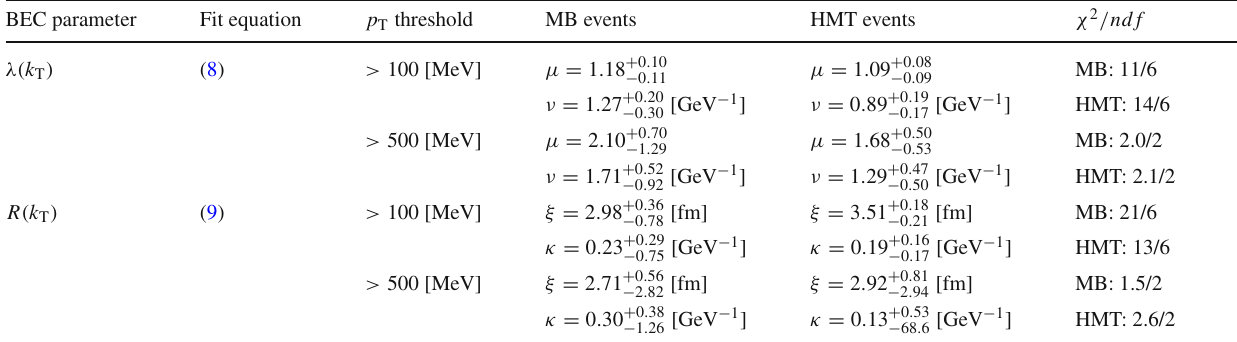
Table 3 The results of the fits to the dependencies of the correla- tion strength, λ , and source radius, R , on the pair average transverse momentum, k T , for various functional forms and for minimum-bias BEC